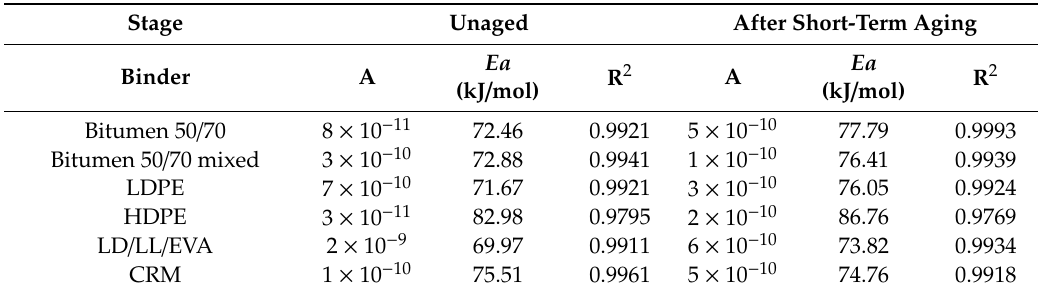
Figure 2. Logarithm of dynamic viscosity against the reciprocal of absolute temperature (Arrhenius plot) for the binder studied: ( a ) before aging; ( b ) after aging at the RTFOT. Table 9. Parameters of the Arrhenius equation for the binders studied before and after aging.